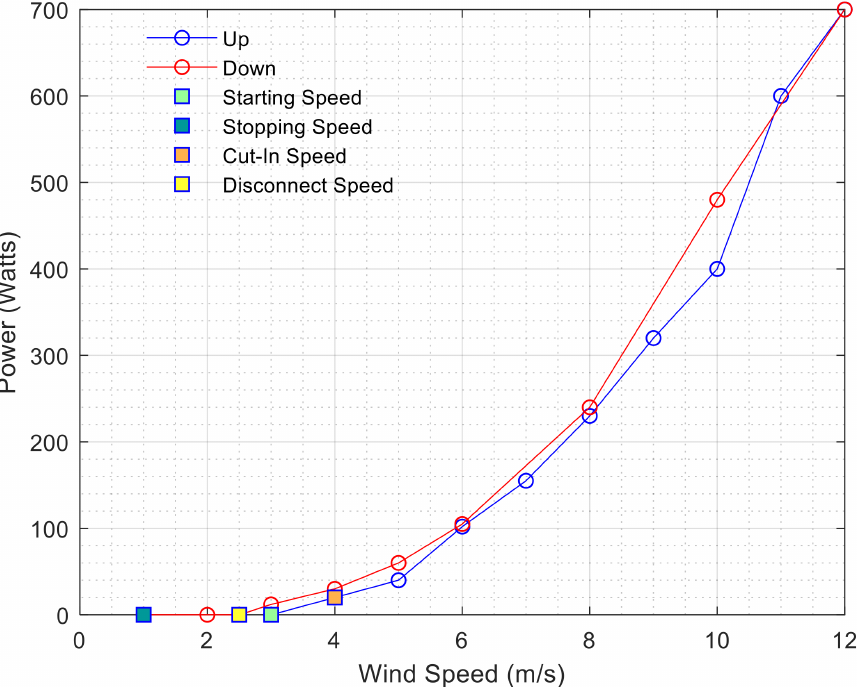
Figure 21. Power curve recordings with an increasing (up) wind speed and then decreasing (down) wind speed. Characterizing wind speeds are noted in the legend